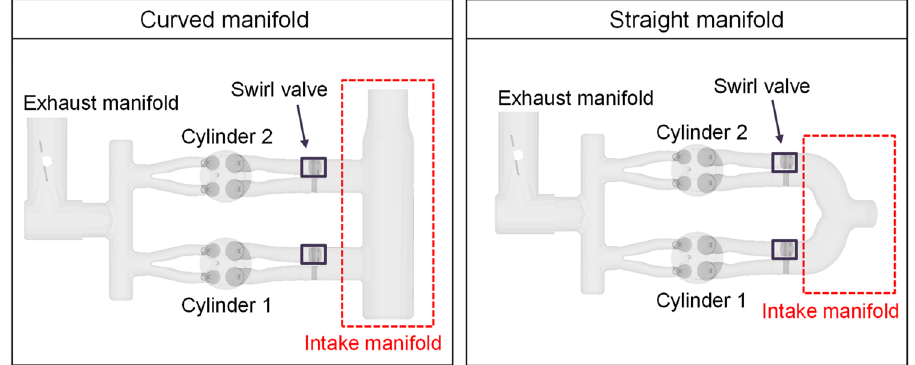
Figure 5. Computational domain for